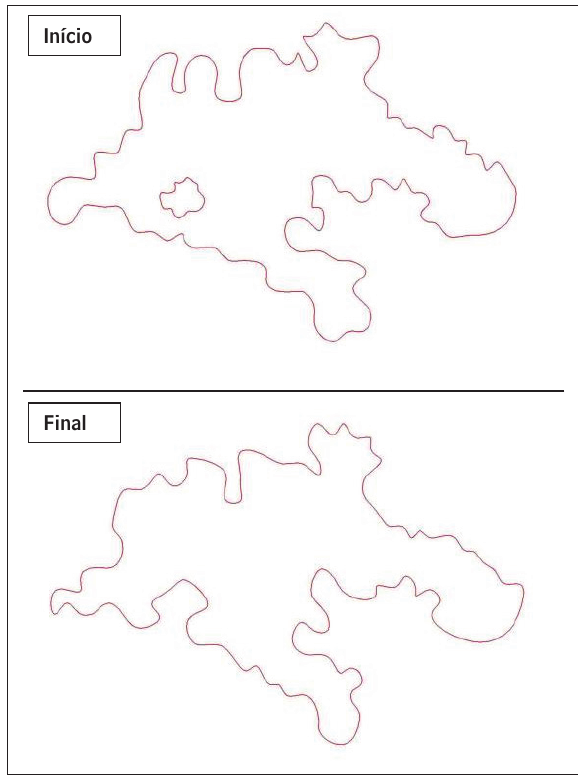
Figura 1 - Delimitação da borda da mácula no AUTOCAD Fonte: Dados da